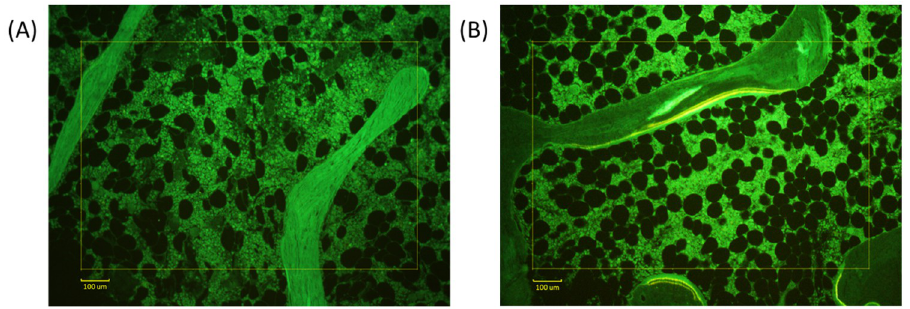
Fig 3. Example of low and non-low bone formation under fluorescent microscopy. Microphotograph of unstained bone section of the same patient viewed under fluorescent light after double tetracycline labeling. Section thickness 7 μ m. Magnification 10X. (A) In low bone formation, no evidence of tetracycline uptake. (B) In non-low bone formation, apposition sites exhibiting double labeling.